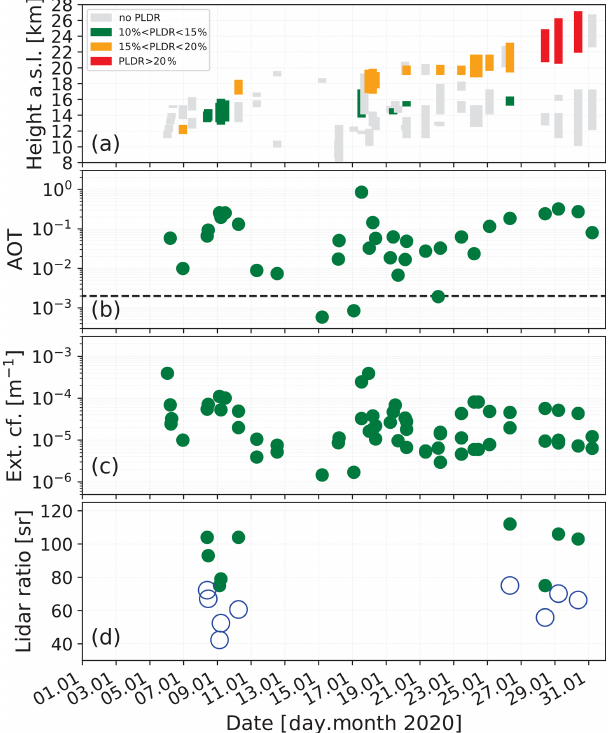
Figure 5. (a) Overview of Polly observations of stratospheric smoke layers (thick bars) from 6 to 31 January 2020. The color of the bar indicates the layer mean 532nm particle linear depolarization ra- tio (PLDR). If no trustworthy PLDR solution could be obtained, the bars are gray. (b) 532nm AOT of the stratospheric smoke, calculated from the profiles of the smoke backscatter coefficients multiplied by a lidar ratio of 95sr, (c) layer mean 532nm parti- cle extinction coefficient, and (d) layer mean 532nm lidar ratio (green) obtained from the nighttime Raman lidar measurements. The open blue circles indicate estimated 355nm lidar ratios ob- tained by means of the combined lidar–photometer retrieval method (see text). The dashed horizontal line in (b) shows background AOT level for the Southern Hemispheric stratosphere (Sakai et al., 2016). The different smoke transport regimes below and above 19–20km height as defined in Sect. 3.1 are responsible for the two layer struc- ture (in a ) observed after 20 January